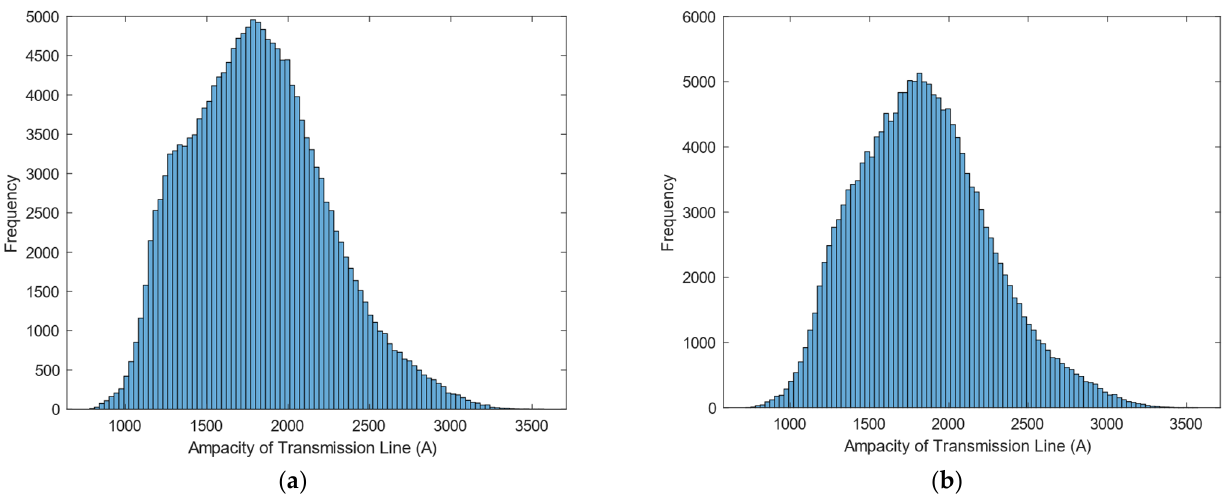
Figure 9. ( a ) Frequency histogram of fuzzy dynamic ratings based on twenty years of meteorological data; ( b ) frequency histogram of crisp ratings based on twenty years of meteorological data.